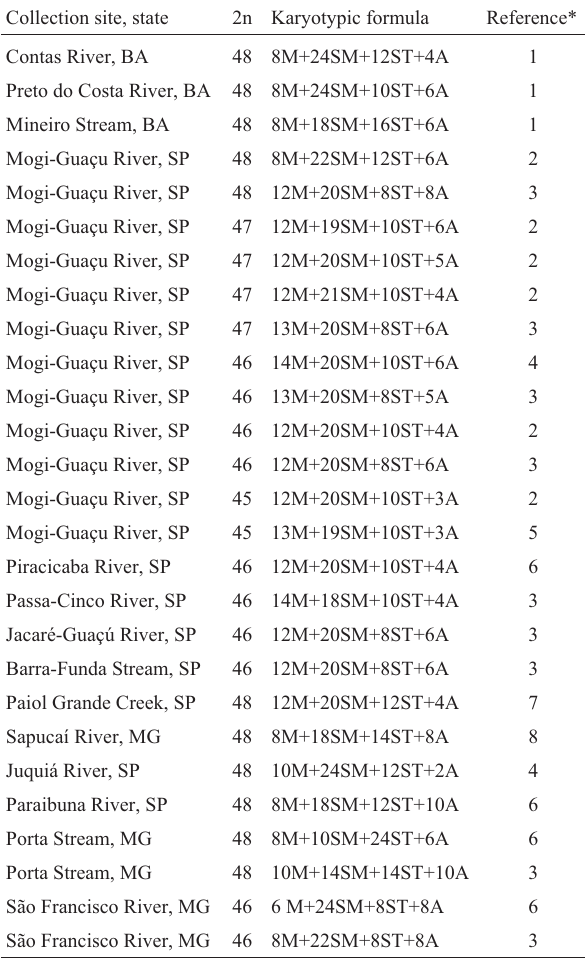
Table 4 - Cytogenetic data on populations of Astyanax fasciatus from Brazil. Collection site,